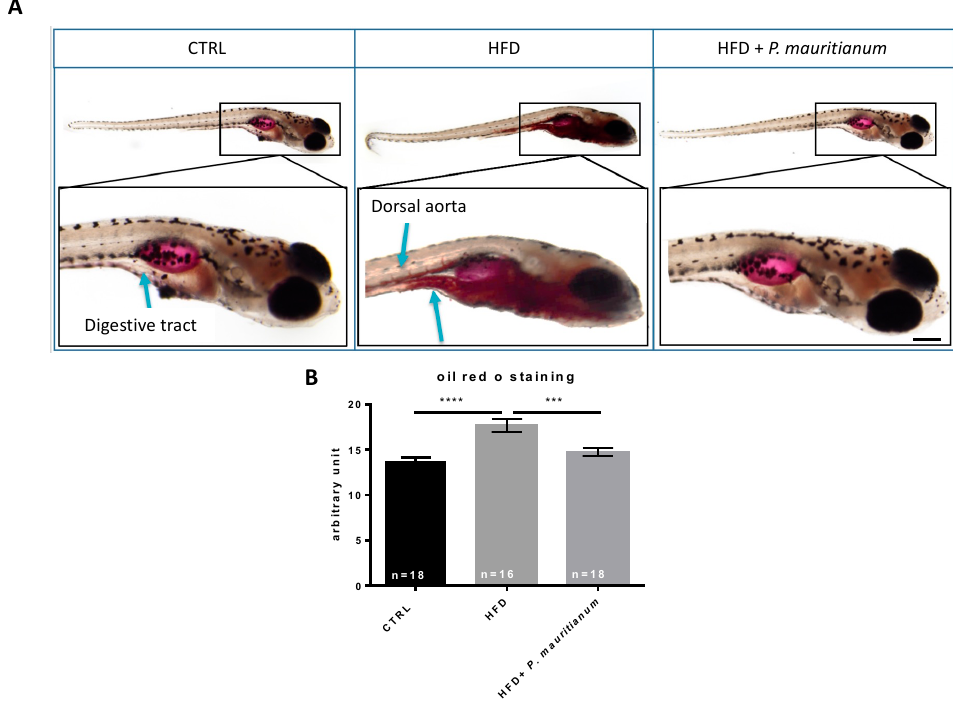
Figure 4. Aqueous extract of P. mauritianum prevents lipid accumulation in HFD larvae. ( A ) Representative pictures of ORO staining in CTRL, HFD and HFD + with P. mauritianum (0.25 g/L). ( B ) Bar graph showing ImageJ ORO staining quantification in CTRL, HFD and HFD + P. mauritianum demonstrating the efficiency of HFD treatment on lipid accumulation and the preventive effects of P. mauritianum on lipid accumulation. n = 16–18 larvae from 2 independent experiments. Bar graph: standard error of the mean (SEM). One-way ANOVA ( B ). *** p < 0.001; **** p < 0.0001. Bar: 100 μ m for low-magnification and 400 μ m for high-magnification larva image.